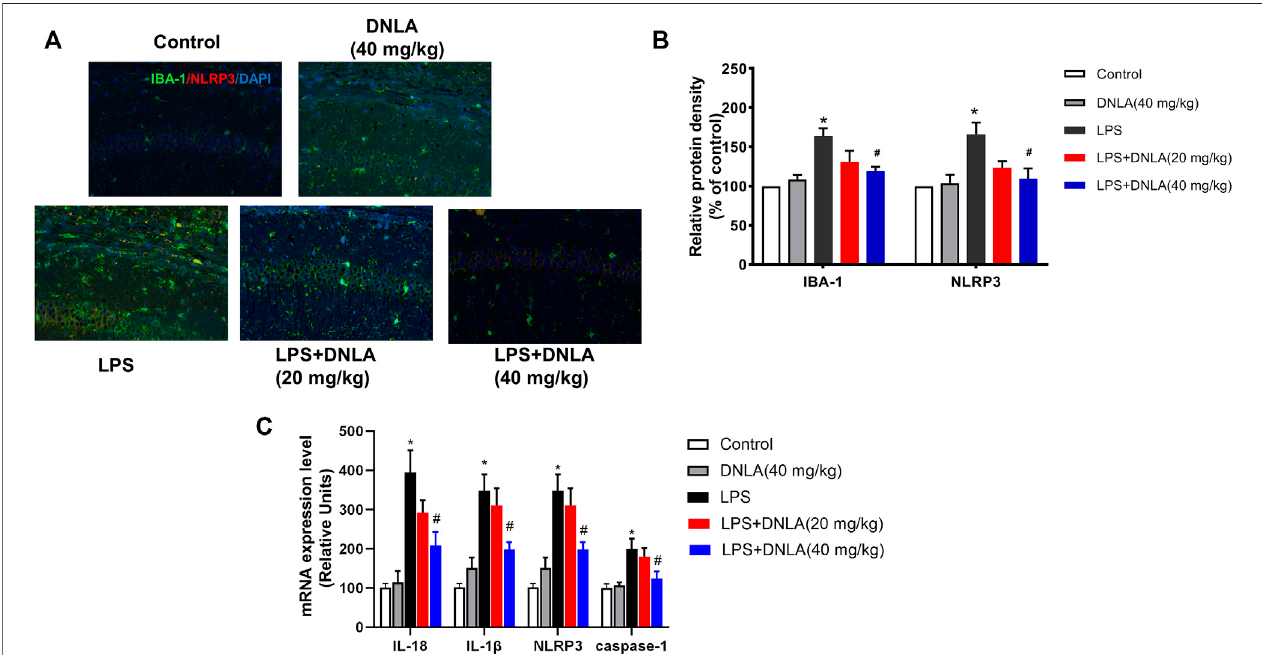
FIGURE 3 | DNLA inhibited microglia and NLRP3 activation. After DNLA treatment for 14 days, the protein expressions of IBA-1 and NLRP3 in the hippocampus CA1 region were measured by immuno fl uorescence staining. The red color indicated NLRP3, the green color presented IBA-1, and the blue one exhibited a DAPI- stained nucleus. Scale bar = 50 μ m (A) . Quantitative analysis of protein density of IBA-1 and NLRP3 (B) . mRNA levels of NLRP3, IL-18, IL-1 β , and caspase-1 in the hippocampus were tested by real-time RT-PCR (C) . * p < 0.05 compared with the control group; # p < 0.05 compared with the LPS-treated group. Data were expressed as mean ± SEM, n =